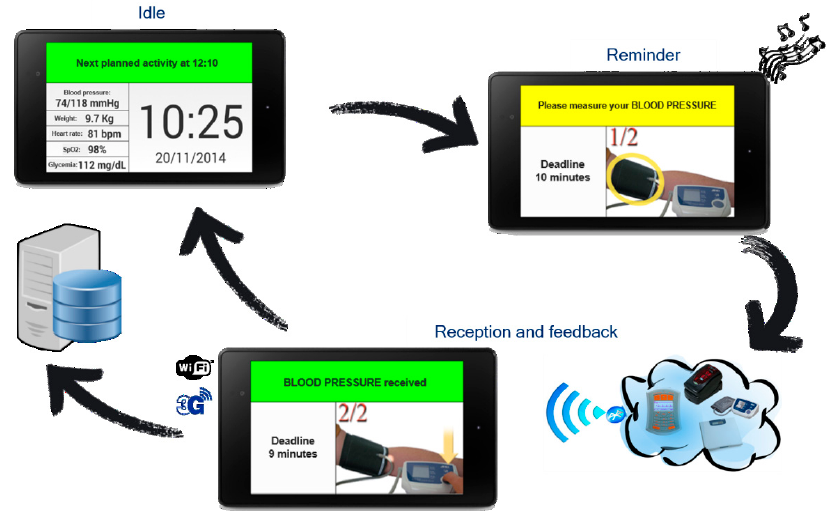
Figure 3. Example of blood pressure acquisition and transmission with the patient-oriented gateway.